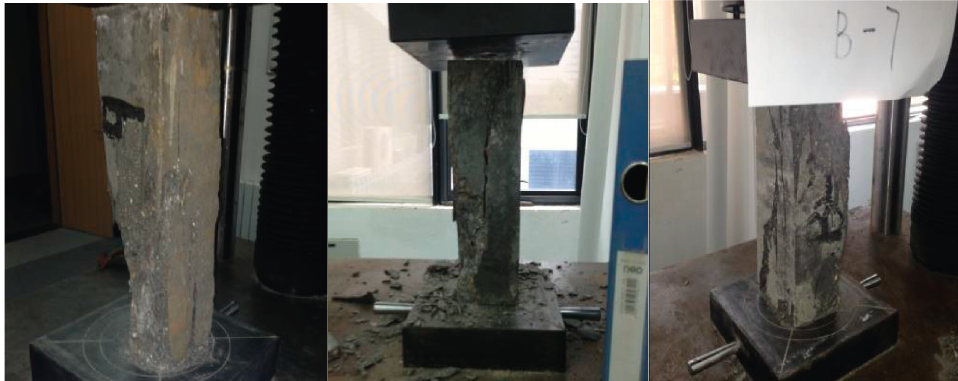
Figure 2: Shear failure as the major failure mode of prism specimens.